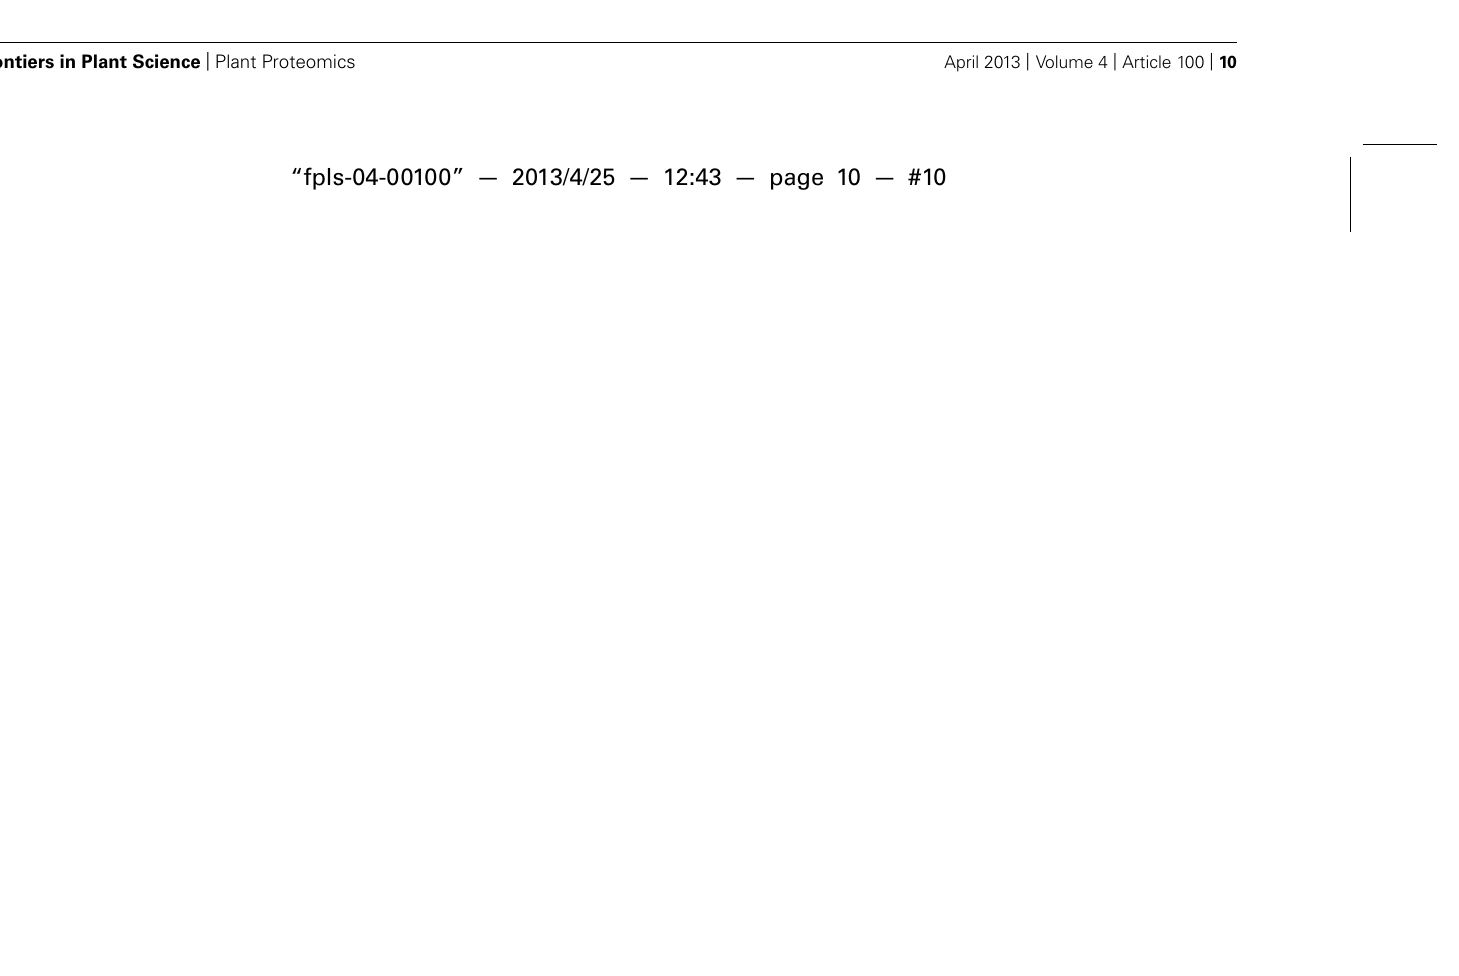
Frontiers in Plant Science | Plant